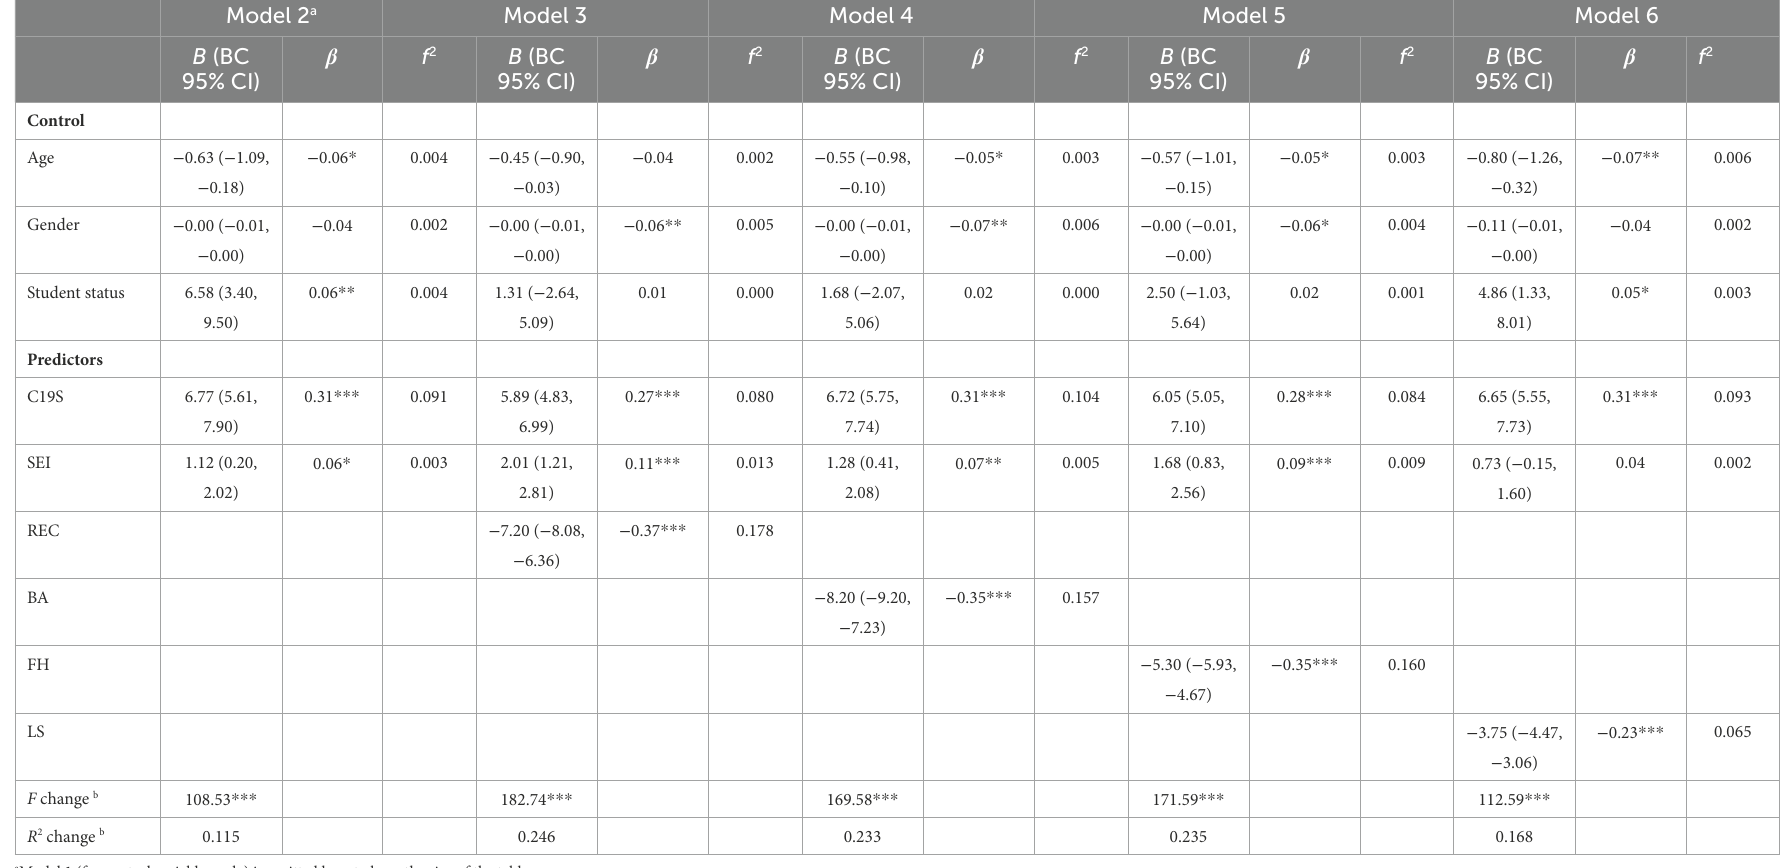
TABLE 4 Discrete multiple regression analyses for the predicting effects of COVID-19 stress and stress due to social event and positive psychological factors on